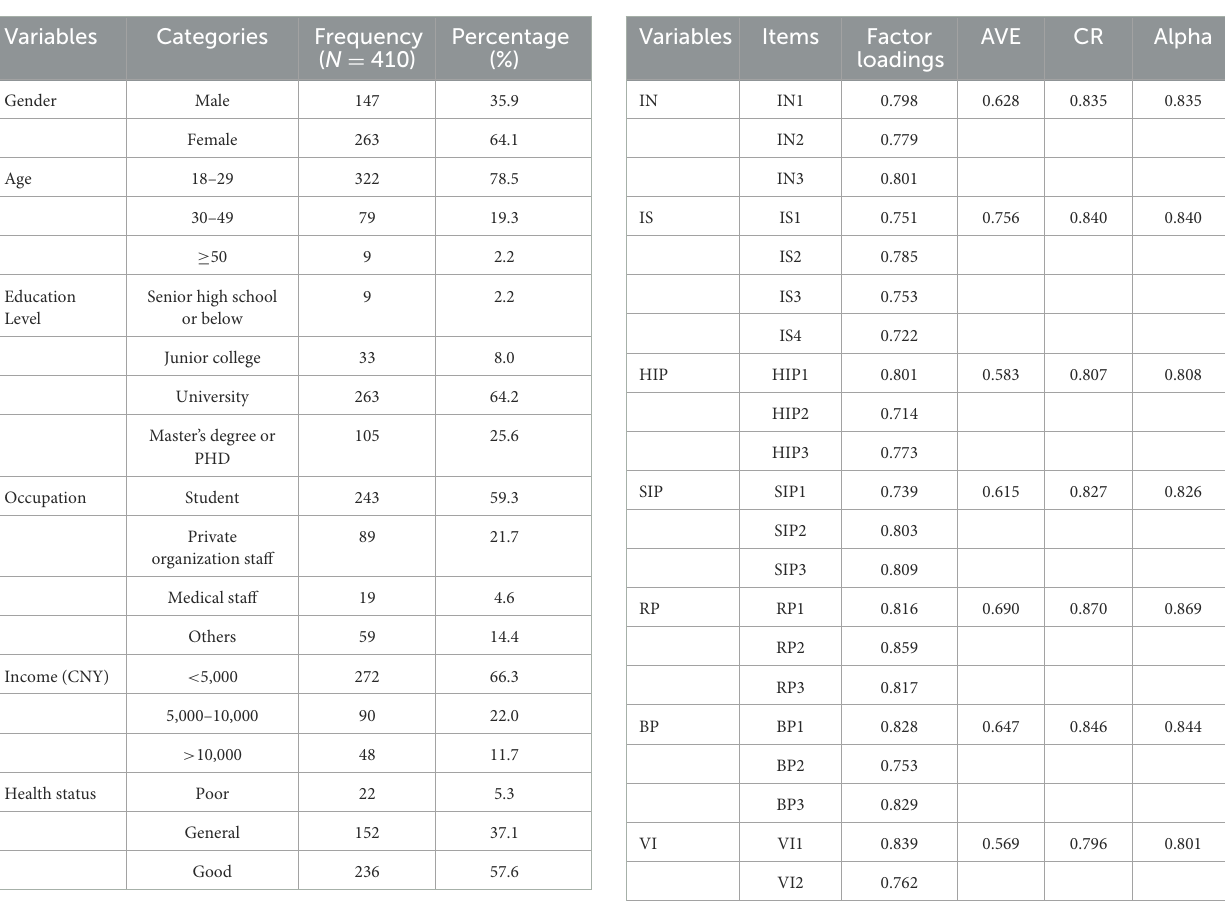
TABLE 2 Sociodemographic characteristics. TABLE 3 Confirmatory factor analysis results for measurement model.